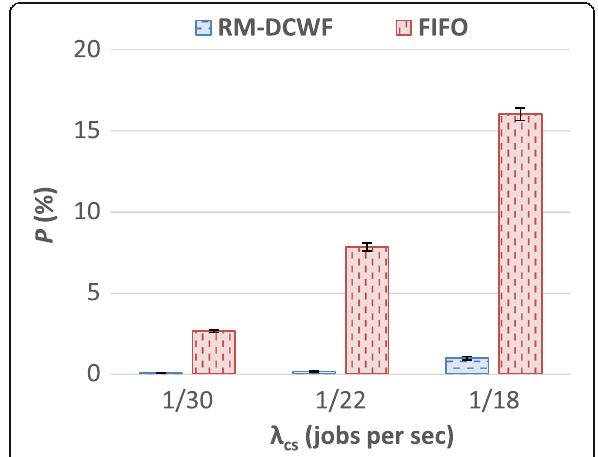
Fig. 16 RM-DCWF vs FIFO: effect of λ cs on P when using the CyberShake workload